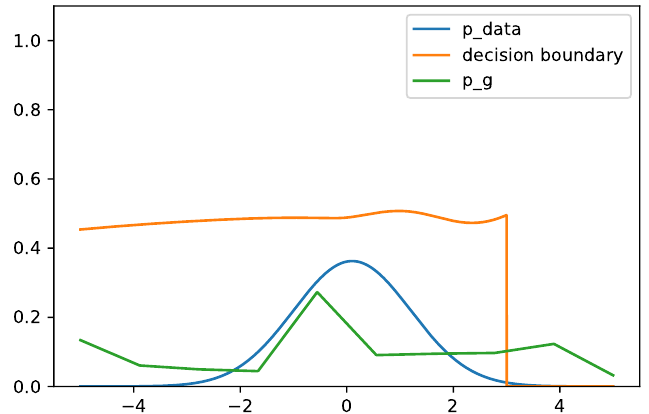
Figure 4. This figure illustrates the generation of new dataset with a GAN considering a Gaussian distribution with µ = 0 and σ = 1. We observe that more data points have been created in the tails as depicted by the green line, compared to the initial distribution represented by the blue